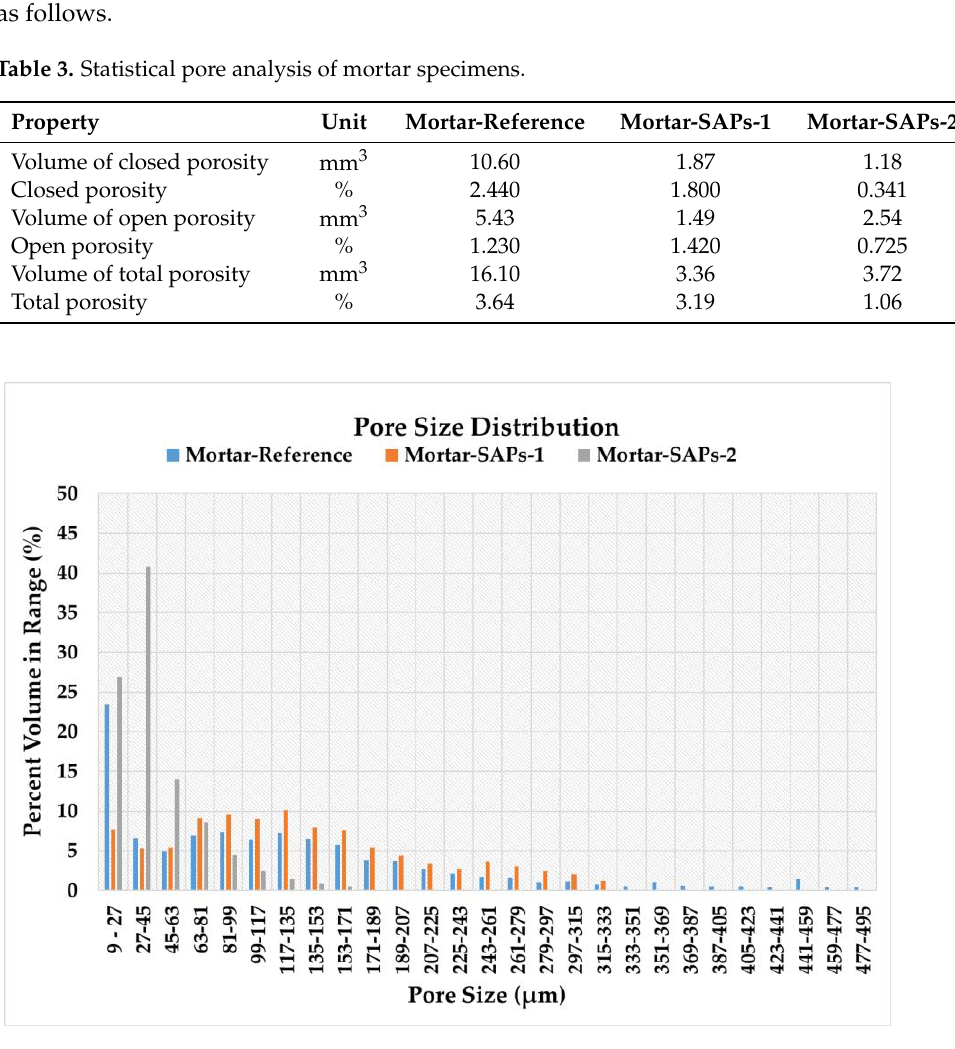
Figure 7. Pore size distribution in mortar-reference, mortar-SAPs-1 and mortar-SAPs-2.